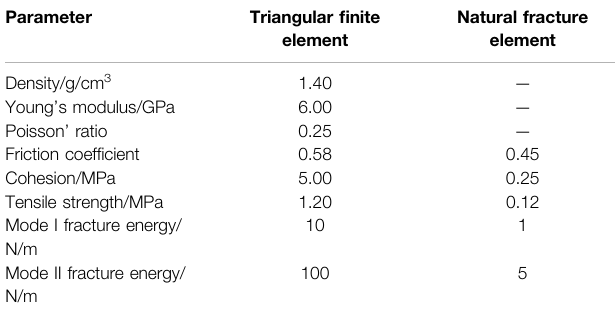
TABLE 2 | The input parameter for FDEM model for case 1.